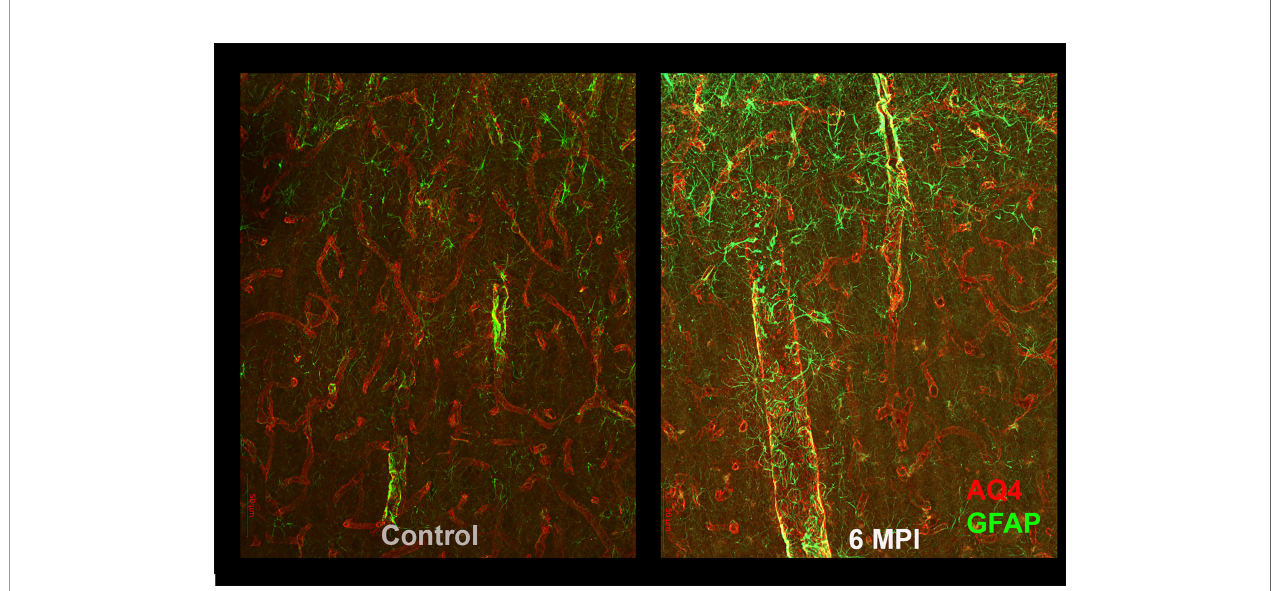
FIGURE 2 | As compared to controls (right panel), reactive astrogliosis can be appreciated as an increased GFAP reactivity and morphological changes in astrocytes 6 months after brain injury. These changes are likely to affect the blood-brain barrier and the glymphatic system and thus the clearance of potentially toxic substances such as